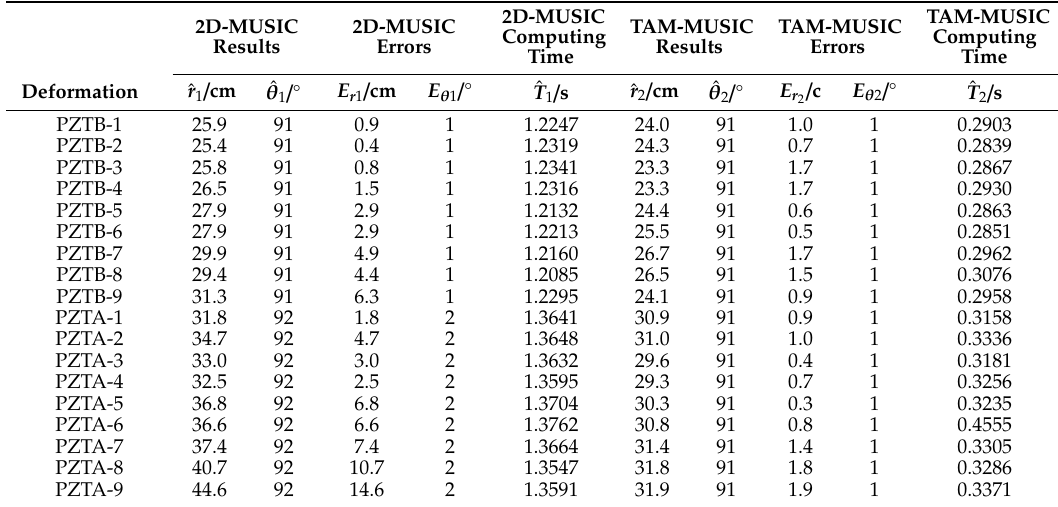
Figure 8. Spatial spectra of two methods under deformation degree 5 when PZTB was excited: ( a ) 2D-MUSIC algorithm; ( b ) TAM-MUSIC method.